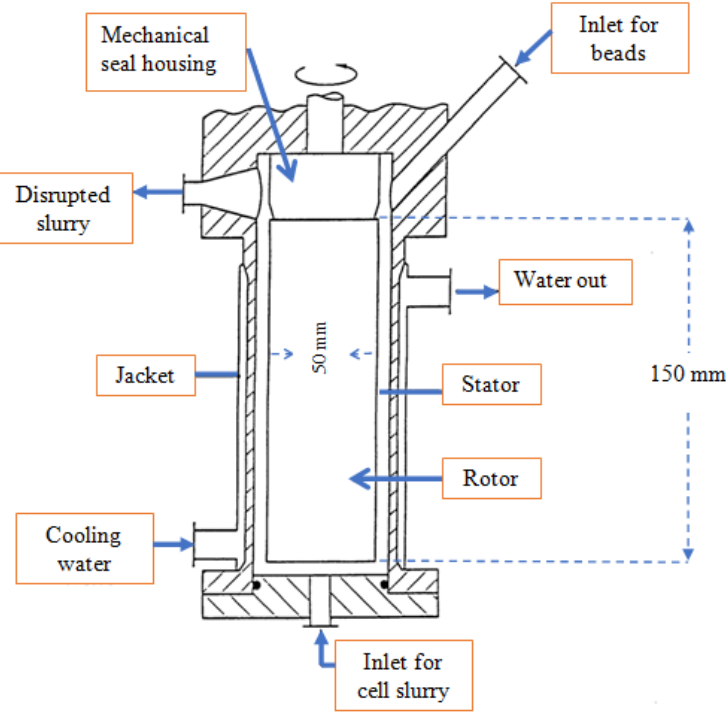
Figure 2. A schematic diagram of the bead mill disruption chamber [56]. Adapted with permission from Springer Nature (1998 Springer-Verlag). Table 1. Effects of the parameters of the bead-beating technique for the cell disruption of